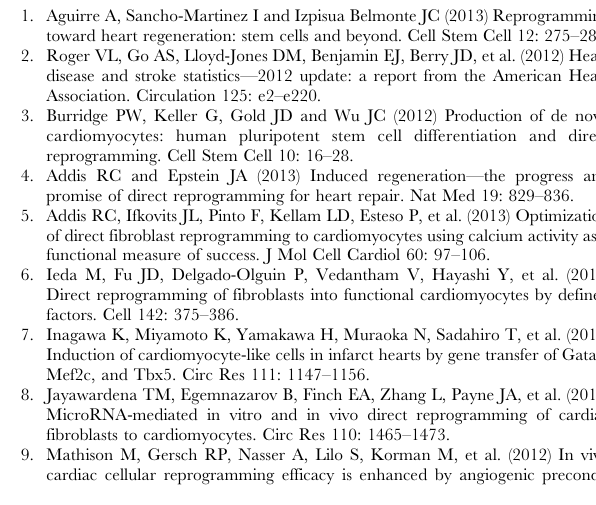
Figure S1 Immunocytochemistry staining for iCMs generated from MEFs at Day 14 post-induction. Scale bar is 50 m M. Figure S2 Inhibition of TGF b signaling ligands in MEFs leads to increased iCM yield. Troponin T-GCaMP analysis at Day 14 post-induction with DMSO vehicle control, LY364947 (LY) that inhibits TGF b alone, and SB that inhibits TGF b and Activin/Nodal components of the superfamily (A). Oil Red O staining for adipocytes also present in cultures of iCMs generated from MEFs and treated with the different small molecules at Day 14 post-induction. Scale bar is 200 m M. Figure S3 Evaluation of Nkx2.5-V5 transgene expres- sion (green) at Day 2 post-induction between DMSO and SB treatment groups (A). Time course staining for TUNEL (green) and DAPI (blue) for iCMs derived from MEFs at Day 2, Day 4, and Day 7 post-induction for + DMSO (top row) and + SB (bottom row) (B). Scale bar is 100 m M. Figure S4 Characterization of starting adult mouse cardiac fibroblasts by immunocytochemistry staining for Nkx2.5 (green, A), vimentin (red, B–E), Isl1 (green, B), a -actinin (green, C), a -myosin heavy chain (green, D), and cardiac troponin (green, E). As expected, CFs stain positively for vimenin but negative for markers of cardiomyocytes and cardiac progenitor cells. Scale bar is 100 m M. Figure S5 Representative immunocytochemistry at Day 14 of iCMs for + DMSO (top row) and + 5 m M SB